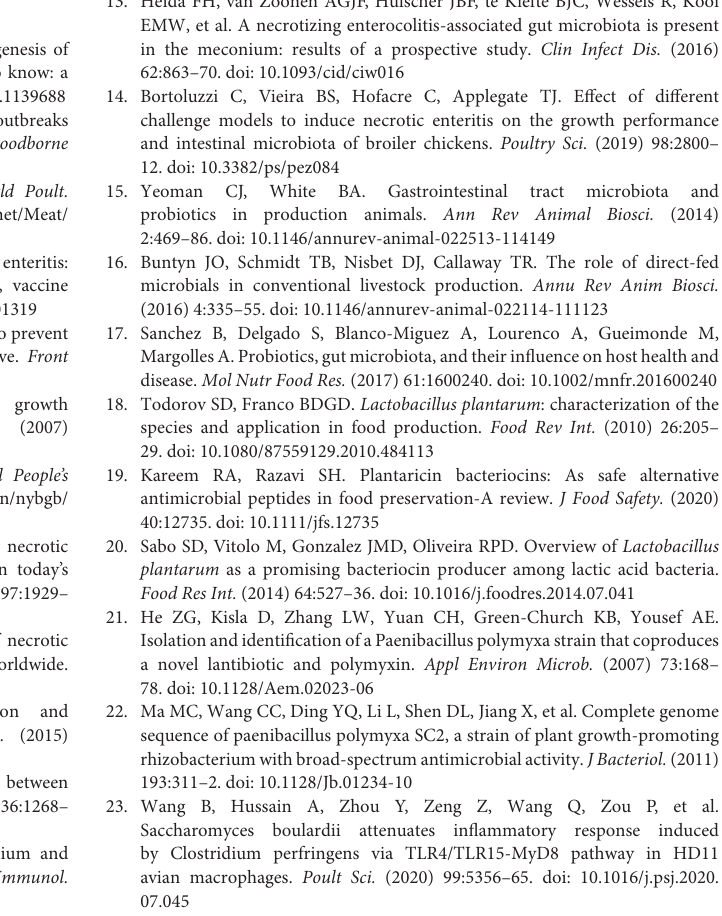
Figure S1 | Probiotics exerts anti- C. perfringens activity. (A) Fermented supernatant of P. polymyxa (BSC10) and L. plantarum (Lac16) significantly inhibited the expression of virulence genes ( α and β toxins) of C. perfringens . Significant differences versus control group: ∗ p < 0.05. (B) BSC10 and Lac16 cultures significantly inhibited C. perfringens growth. (C) Live Lac16 significantly protect C. elegans against C. perfringens infection. Figure S2 | Comparison of predicted pathway abundances between the groups by statistical analysis of taxonomic and functional profiles (STAMP). (A) Control versus Cp; (A) Cp versus BSC10 + Cp; (B) Cp versus Lac16 + Cp. Figure S3 | Canonical correspondence analysis and variation partitioning analysis of the phenotypic variables (including body weight, bursa of fabricius index and spleen index) and ileal SCFAs for the bacterial community (A,C) and microbial predicted pathway functions (B,D) . Figure S4 | Relative abundances of the keystone species. Significant differences versus Control group: # p < 0.05; ## p < 0.01. Significant differences versus